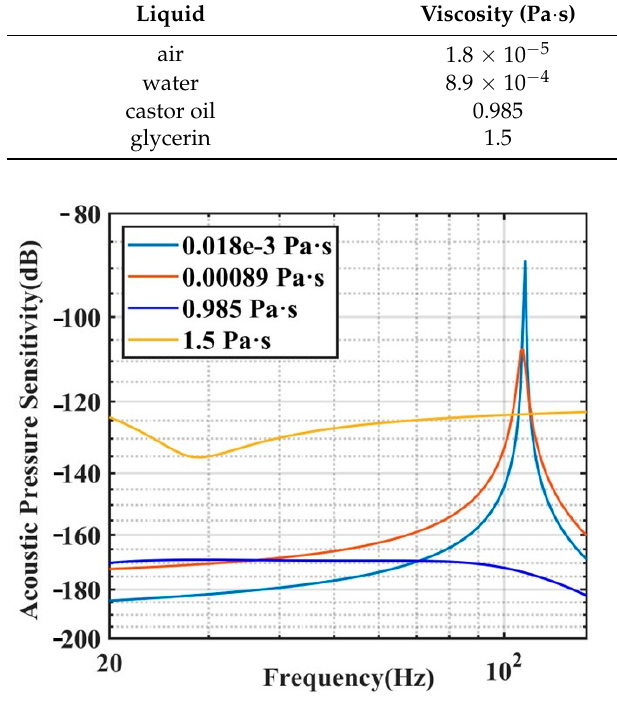
Figure 5. The phase sensitivity of the sensor.